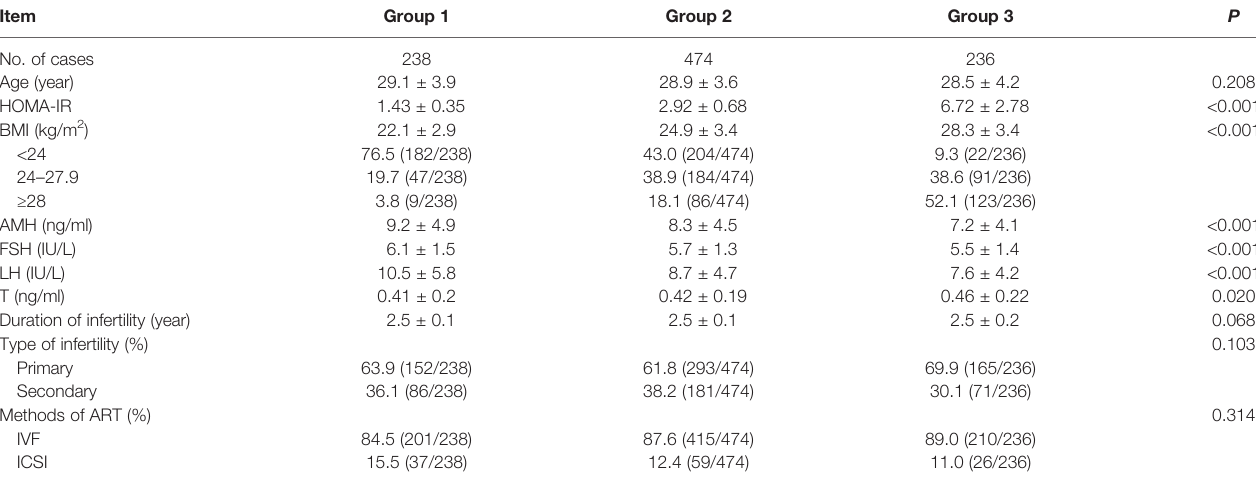
TABLE 1 | Comparison of demographic and clinical characteristics of the three groups.